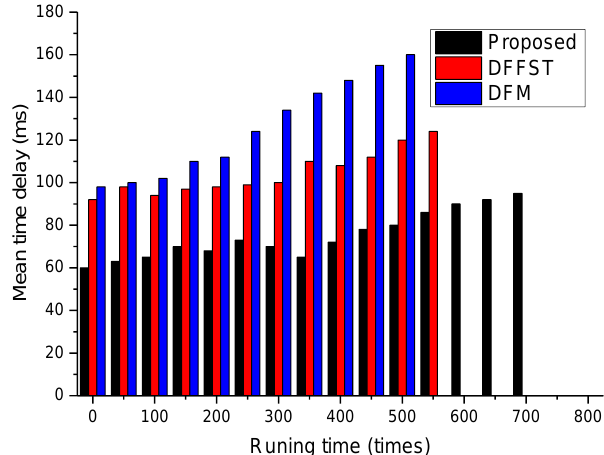
Figure 5. Relationship between the total number of network runs and the average time delay.